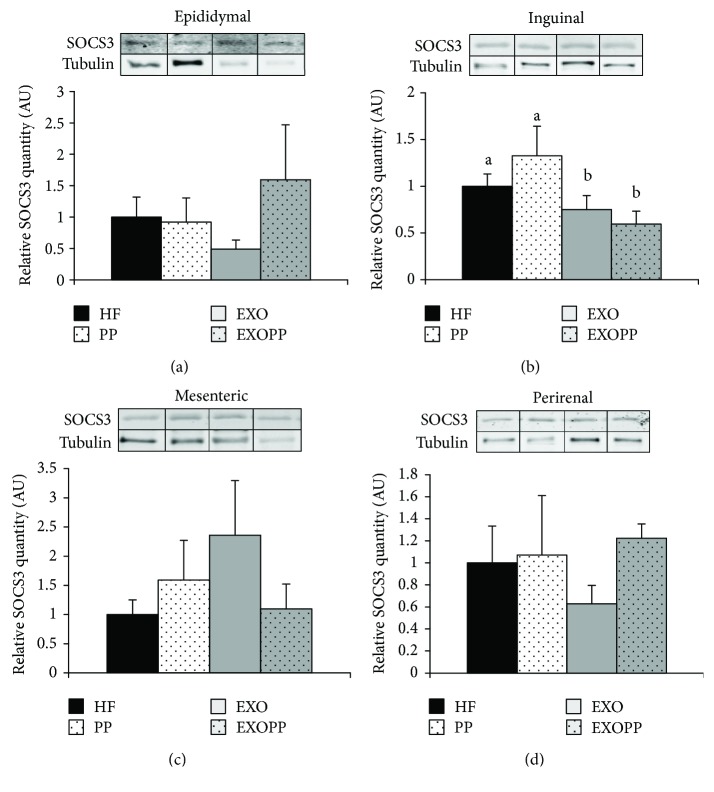
SOCS3 levels in fat stores. SOCS3 protein expression levels were measured by immunoblotting in epididymal (a), inguinal (b), mesenteric (c), and perirenal (d) fat stores. Quantification values are presented as SOCS3 protein levels normalized to tubulin protein levels, used as protein loading control, and are expressed relative to HF group's values, which were set at 1. Data are expressed as mean ± SEM with n = 4 − 5 rats per group. Bars not sharing a common letter are significantly different at p < 0.05.